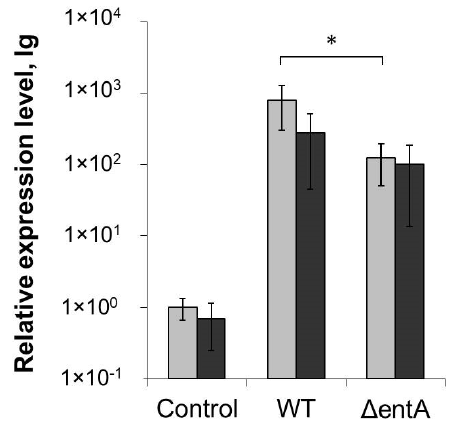
Figure 5. Expression level of LOX2 (lipoxygenase) gene in non-primed (light grey) and salicylic acid-primed (dark grey) tobacco plants non-infected (control) or infected with the wild type (WT) or ∆ entA mutant ( ∆ entA ) of Pectobacterium atrosepticum SCRI1043. The expression levels were determined one day post inoculation. The presented values are means ± SD of four biological replicates. Asterisk (*) shows the significance of difference (Mann–Whitney two-sided test, p < 0.05).